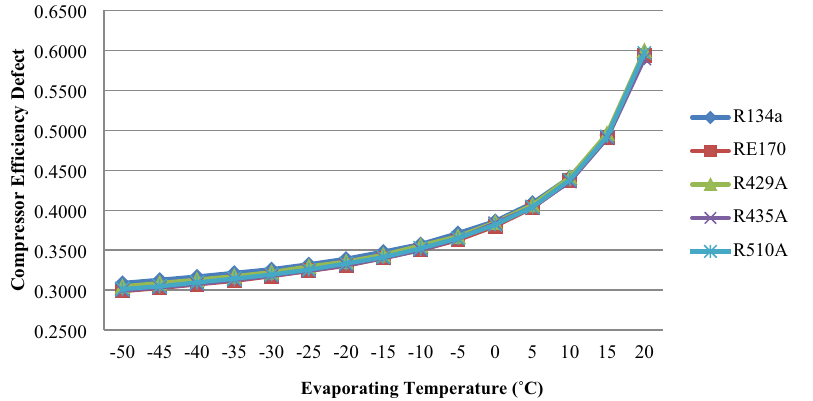
Figure 5. Compressor efficiency defect as a function of evaporator